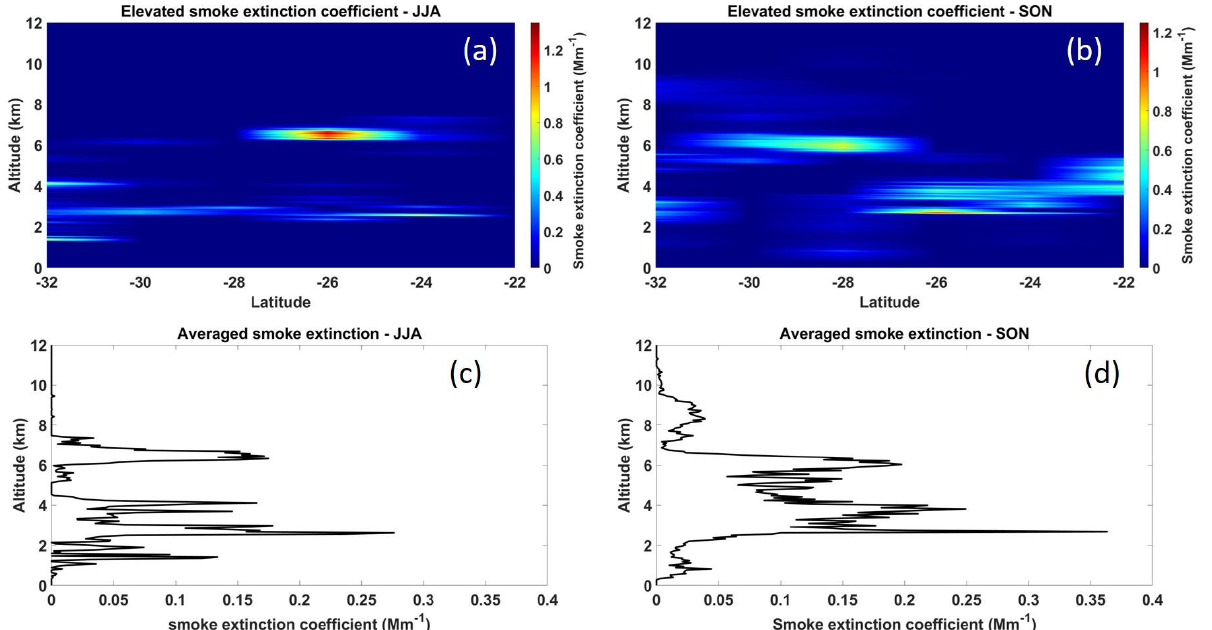
Figure 5. Averaged seasonal vertical height distribution of smoke aerosols over MP and KZN for the period of 2006–2019. Latitude-altitude cross sections of the smoke retrieved extinction coefficients in ( a ) JJA and ( b ) SON seasons. Altitude- resolved profiles of the mean smoke extinction coefficients in ( c ) JJA and ( d ) SON